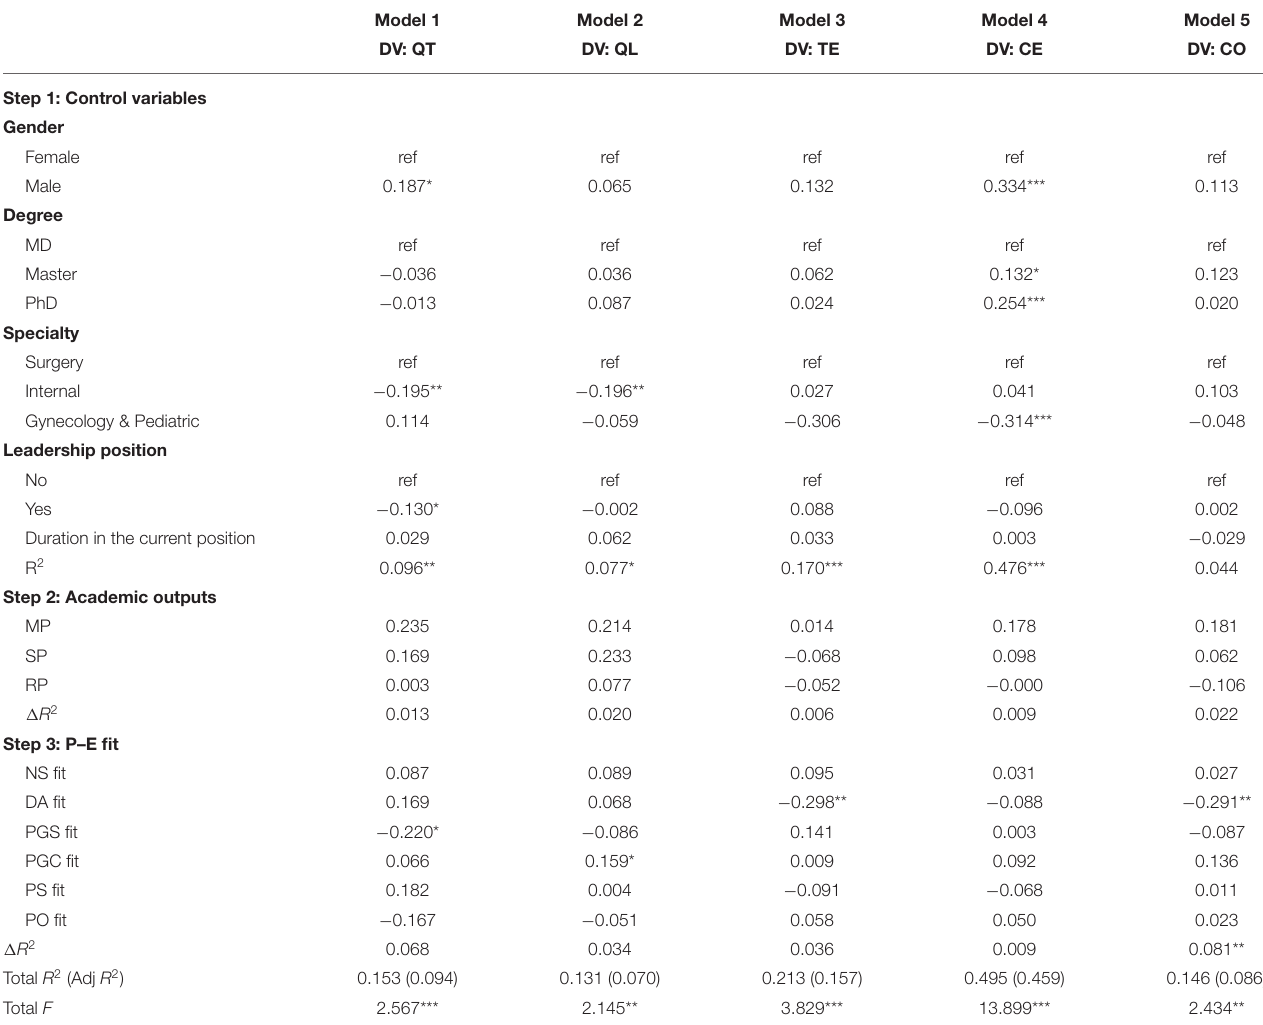
TABLE 3 | Regression results on the relationship between academic outputs, P–E fit, and clinical